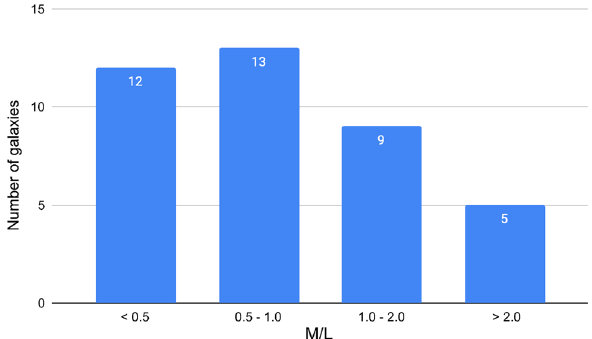
Fig. 8 Distribution of the mass-to-light ratio values ϒ d for the disk for the set of the 27 considered bulgeless galaxies